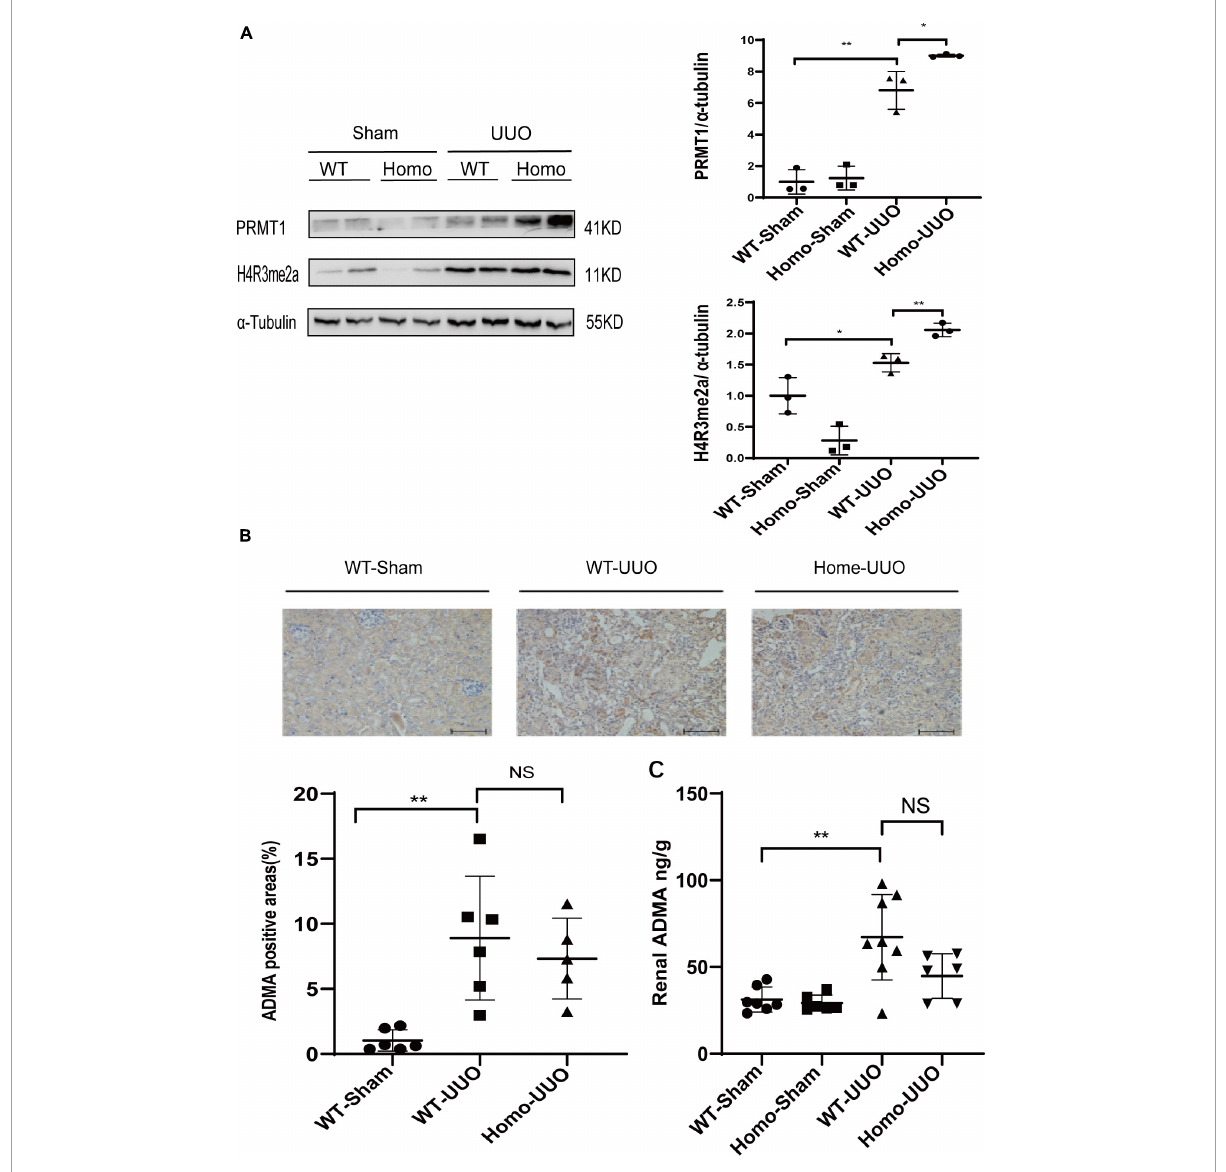
FIGURE2 Changes of histone methylation and ADMA production in fibrotic kidneys after Prmt3 deletion. (A) The expression of PRMT1 and H4R3me2a in WT or Prmt3 Homo mutant c57 mice were analyzed by Western blotting and quantified; (B,C) renal ADMA accumulation in WT or Prmt3 Homo mutant c57 mice were analyzed by immunohistochemistry ( n = 5–6 mice per group) and ELISA ( n = 5–8 mice per group). Bars, 100 µ m. Data represent mean ± SD. One-way ANOVA was used and comparison between two groups was performed by unpaired student t -test. NS represent not significant; * P < 0.05; ** P < 0.01. One representative result of at least three independent experiments is